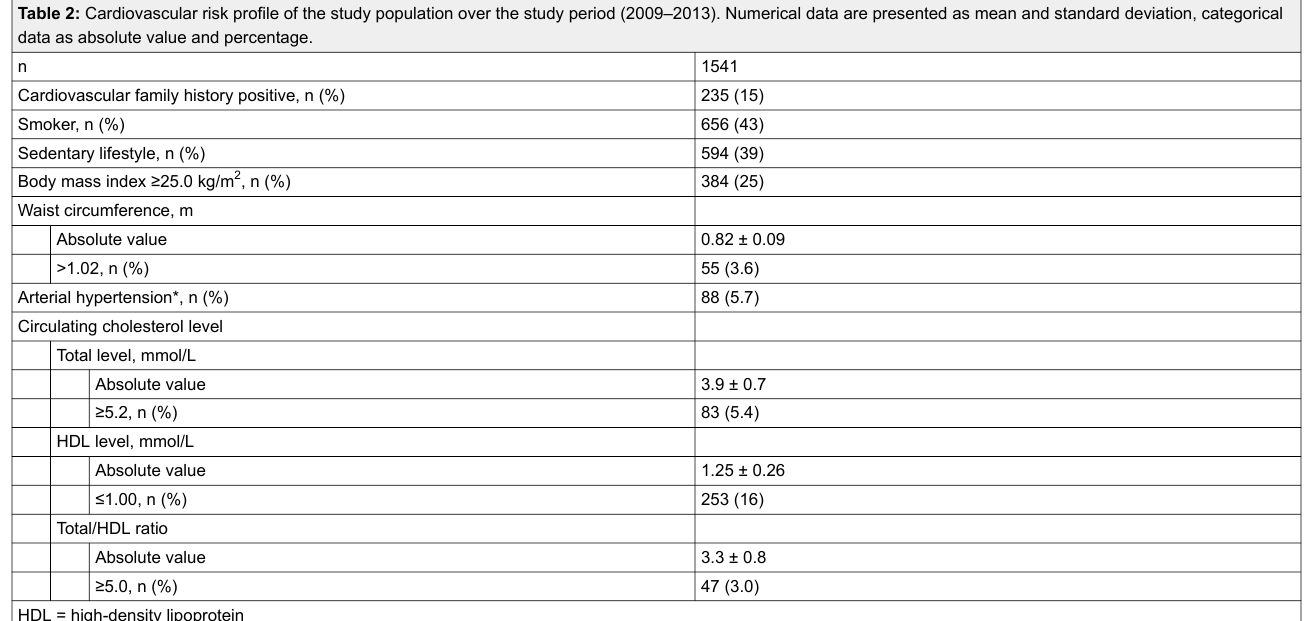
Table 2: Cardiovascular risk profile of the study population over the study period (2009–2013). Numerical data are presented as mean and standard deviation, categorical data as absolute value and percentage.